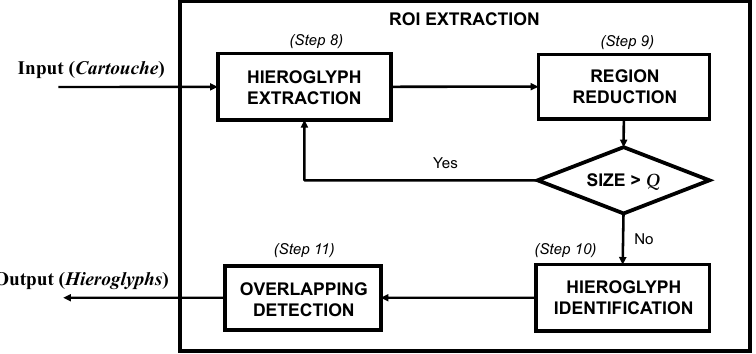
Figure 10. Scheme of the ROI extraction process.